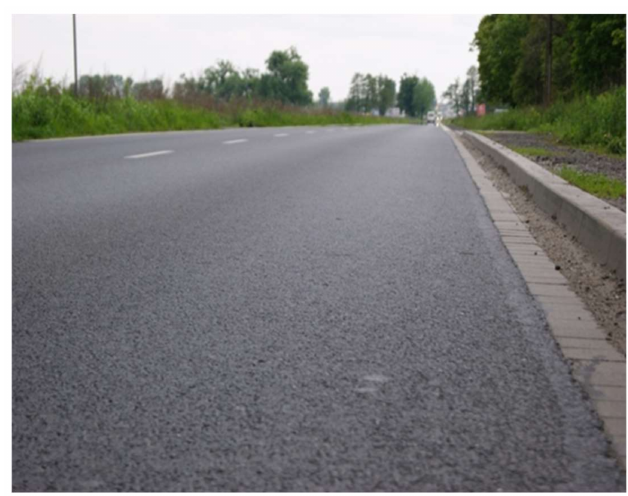
Figure 10. Wearing course layer, SMA